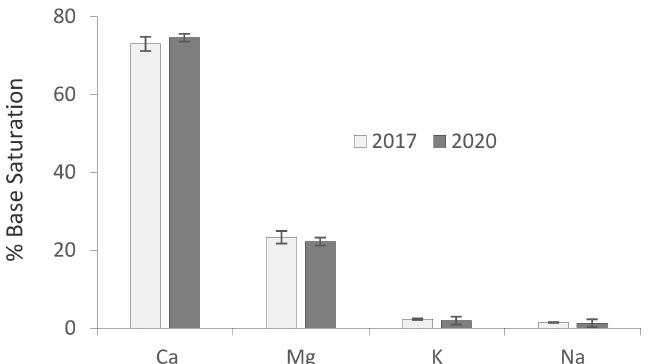
Figure 2. Base saturation in fine sandy loam pastureland after three years of poultry manure application. under flood irrigation with